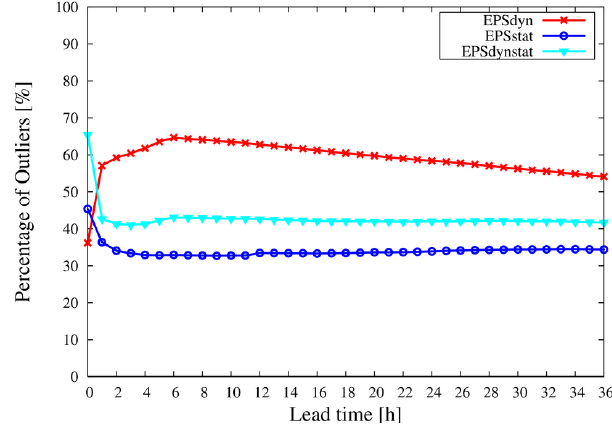
Figure 3. Bias, root mean square error (RMSE) of the ensemble mean, and ensemble spread of the 3 experimental INCA ensembles (dynamical: red, statistical: dark blue, dynamic-statistical: light blue).